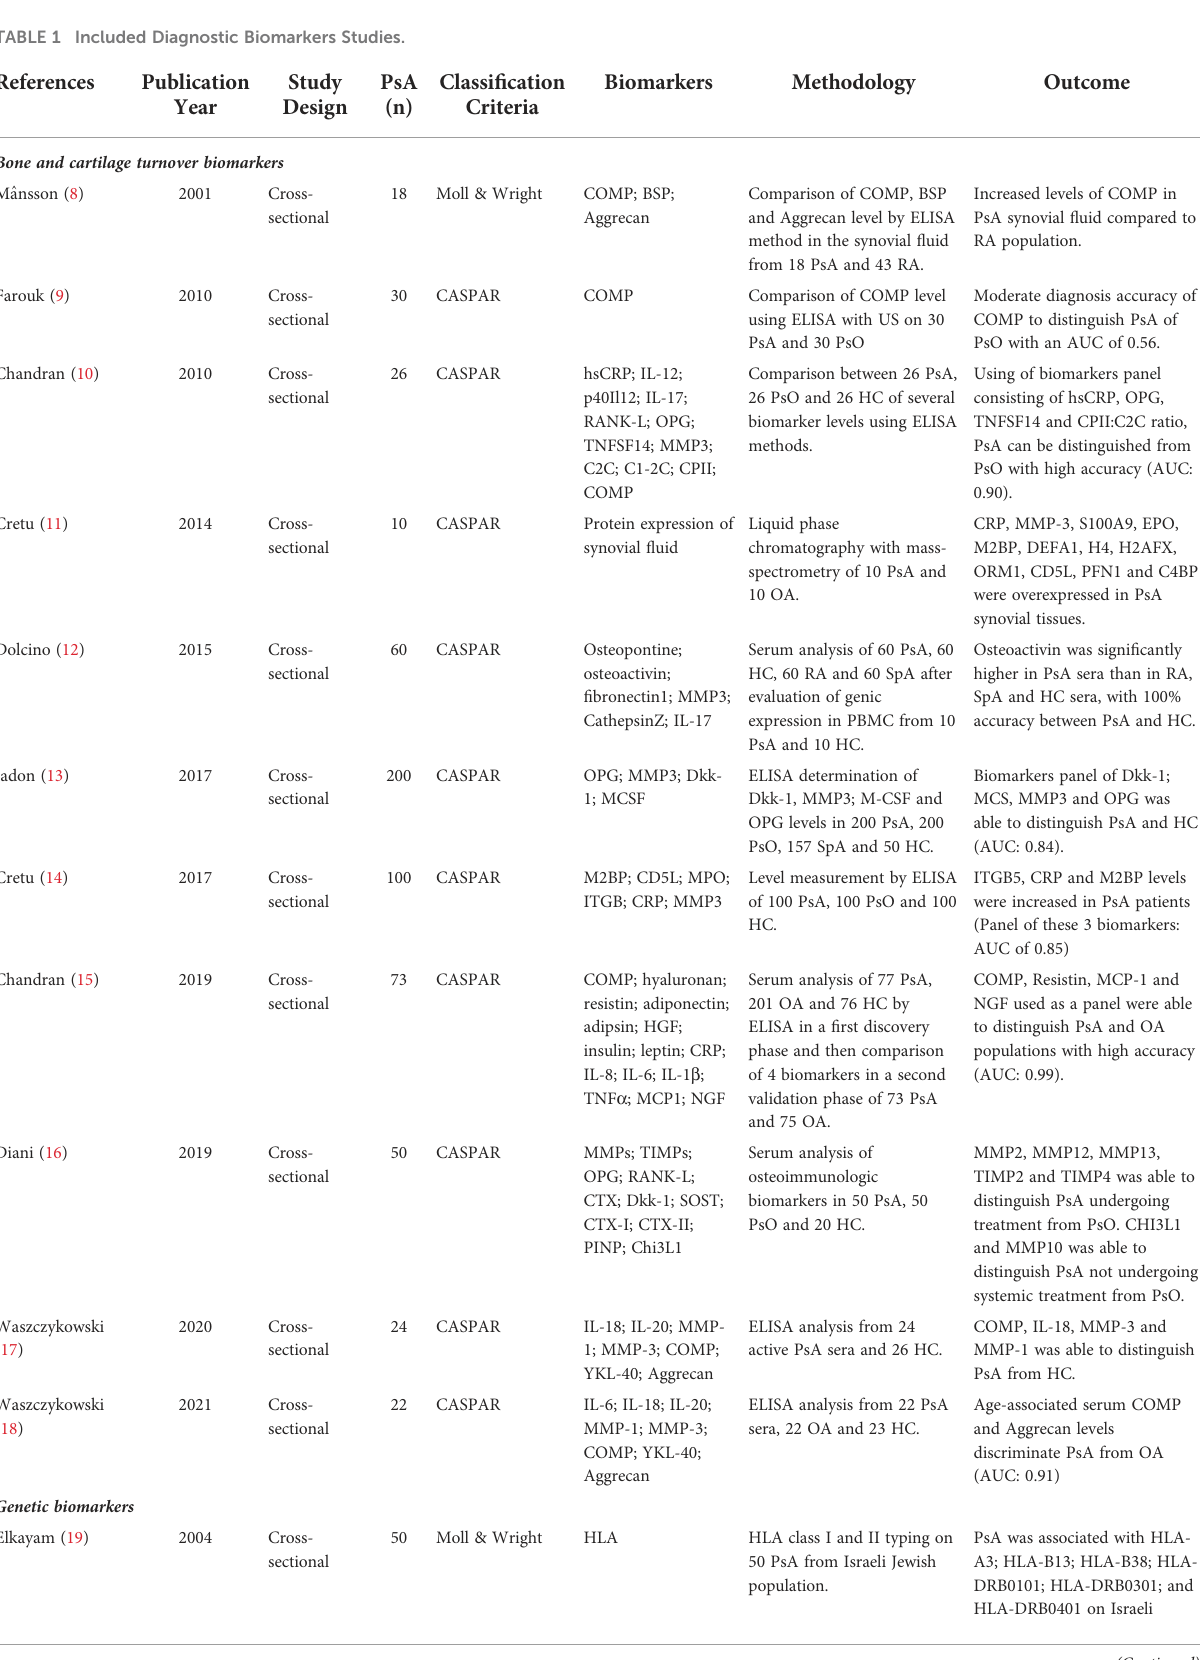
TABLE 1 Included Diagnostic Biomarkers